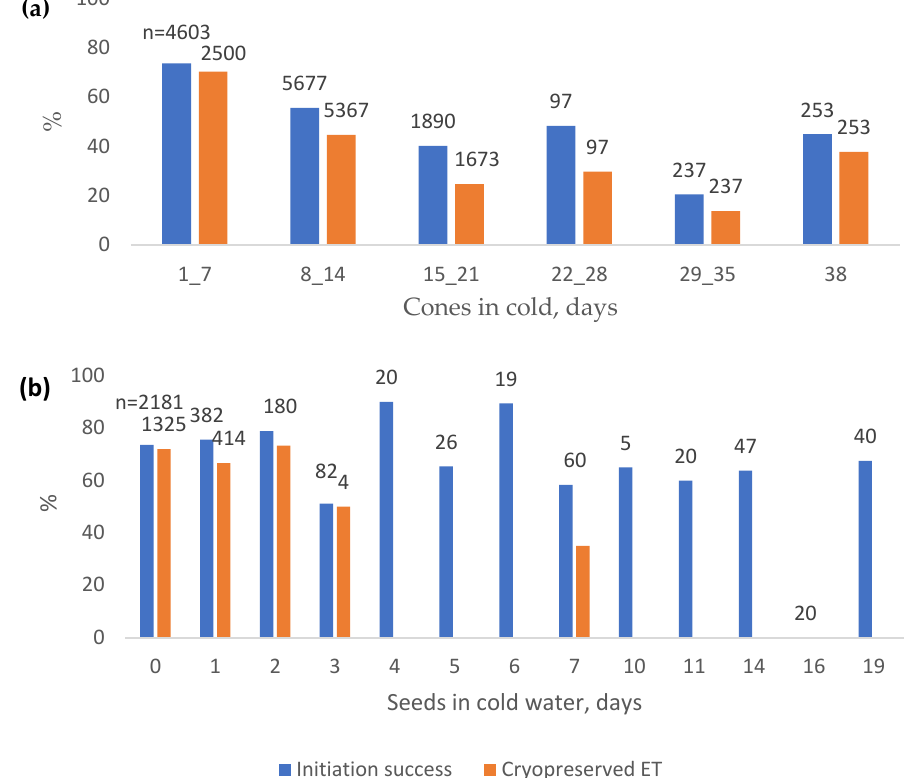
Figure 5. Norway spruce initiation success percentages from 2011 to 2022 and the percentage of initiations which led to cryopreservation from 2014 to 2022 when ( a ) cones were stored at +2 °C, and ( b ) sterilised seeds were stored in cold water at +4 °C. n = number of initiations.